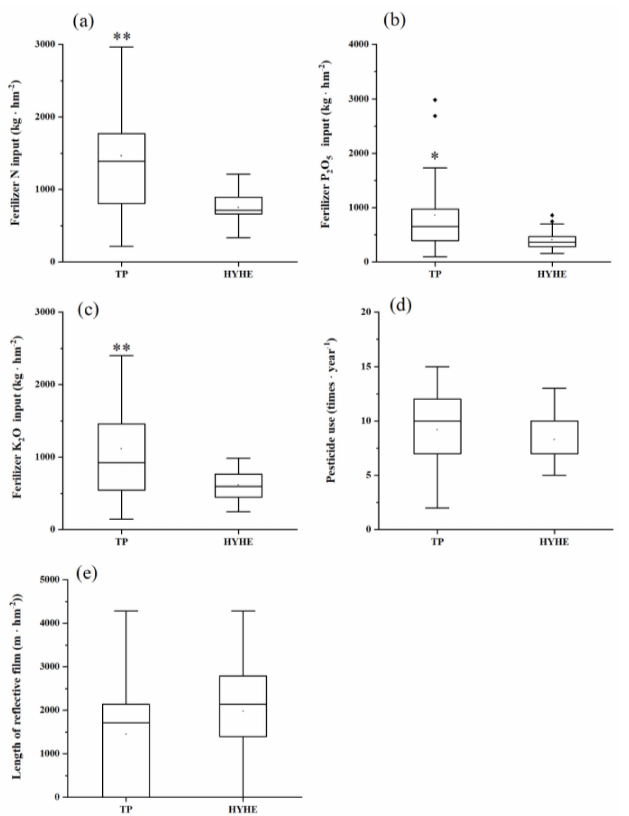
Figure 4. Comparison of indicators between traditional and HYHE farmers. ( a ) Fertilizer N appli- cation; ( b ) fertilizer P 2 O 5 application; ( c ) fertilizer K 2 O application; ( d ) pesticide use; ( e ) length of reflective film. * p < 0.05; ** p <